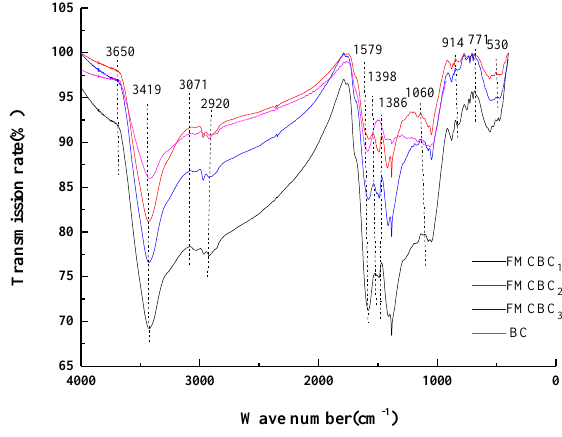
Figure 4. The FTIR spectrogram of FMCBCs.